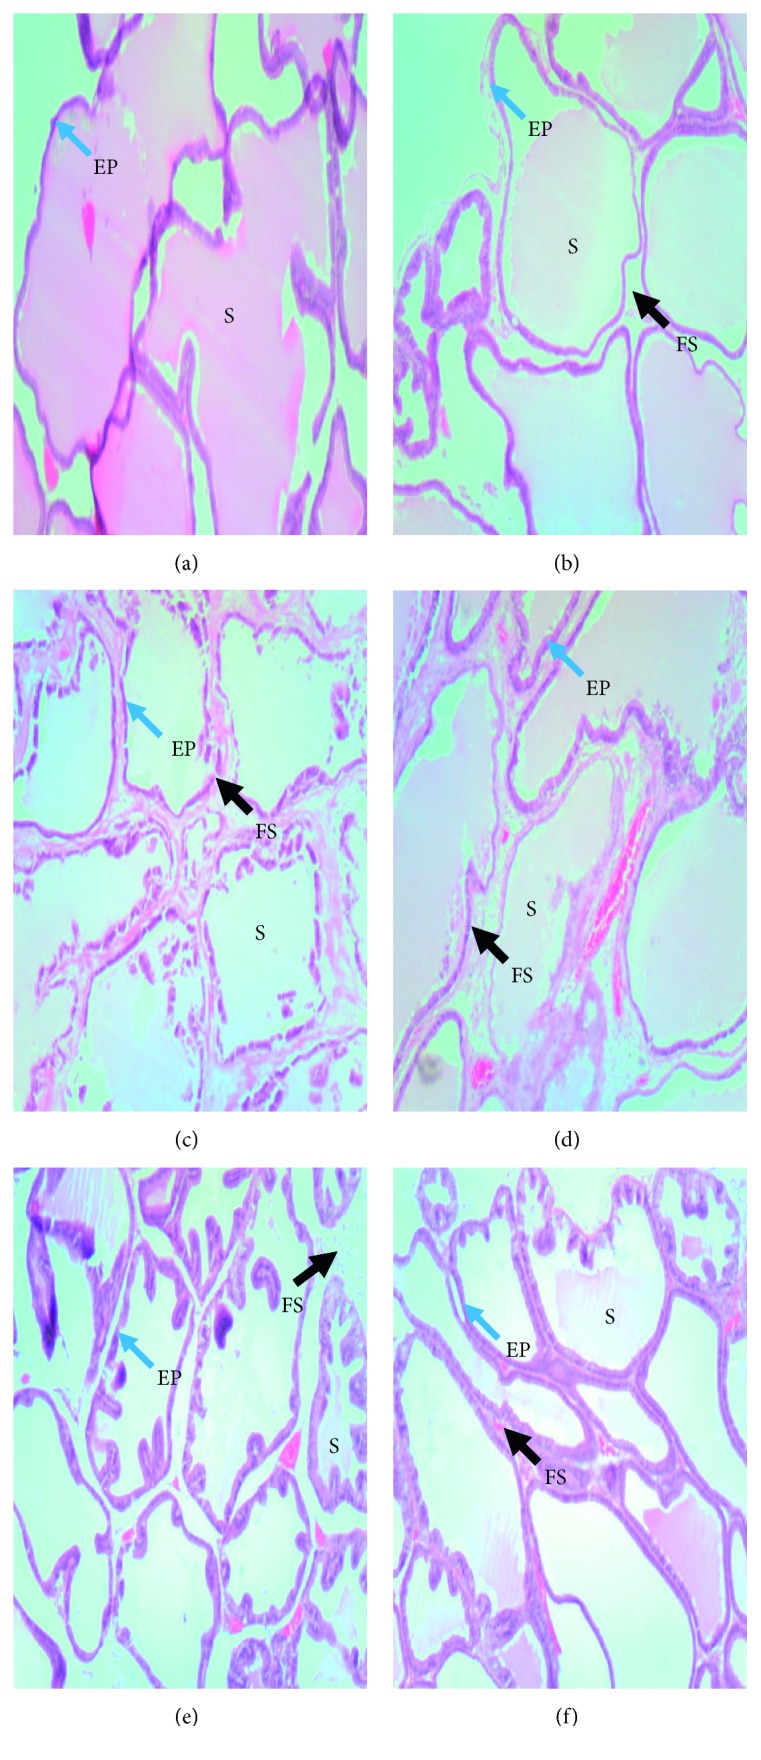
Photomicrographs of prostate glands of experimental groups after 21 days of treatment: (a) model; (b) low dose of oil (30 mg/kg); (c) mid-dose of oil (100 mg/kg); (d) high dose of oil (300 mg/kg); (e) finasteride (15 mg/kg); (f) normal control. Prostatic secretions (S), epithelium (EP), and fibromuscular stroma (FS), model group had larger acini with thicker epithelium, more prostatic secretions, and thinner fibromuscular stroma. Low dose group had slightly large acini, light prostatic secretions and thin fibromuscular stroma. Mid-dose group shows smaller acini with thinner epithelium, moderate prostatic secretion, thick strand of the fibromuscular stroma. High-dose group shows small-sized acini, moderate prostatic secretions, thin epithelium and thick fibromuscular stroma. Finasteride group had almost absent prostatic secretions and a very few amount of fibromuscular stroma, sham group had small-sized acini, little or no prostatic secretion, together with few strands of the fibromuscular stroma.